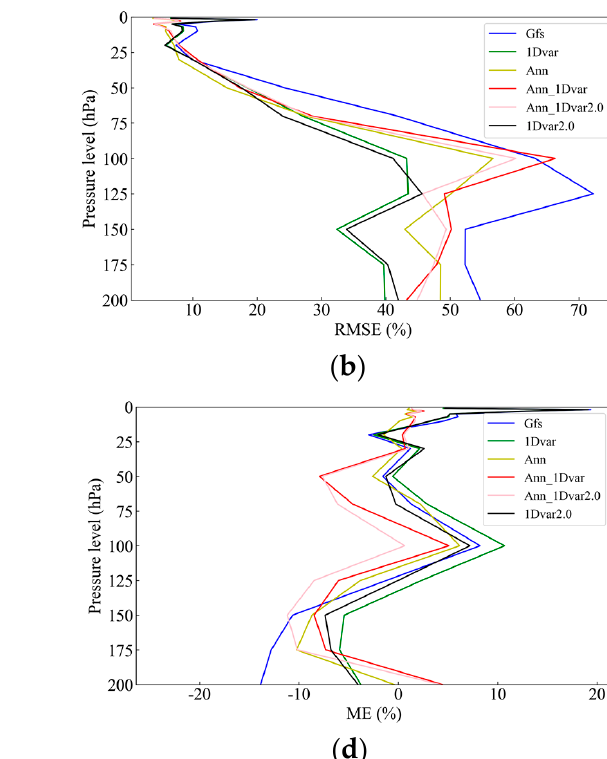
( d ) Figure 11. A comparison between the retrieved profile and AIRS product profile, where the true values are taken from WOUDC ozone site data: ( a ) 10–600 hPa RMSE (%), ( b ) 10–200 hPa RMSE (%), ( c ) 10–600 hPa ME (%), ( d ) 10–200 hPa ME (%). The red line, 1Dvar, is the traditional 1D − VAR phys- ical retrieval algorithm retrieval ozone profile result obtained with GFS data as the initial profile. The green line, Ann_1Dvar, is the retrieval result obtained by adding the neural network method to optimize the initial profile combined with the traditional 1D − VAR physical retrieval algorithm. The blue line, AIRS, is the ozone profile of AIRS L2 Ozone product. 4.3. Effects of Temperature and Water Vapor on Ozone Retrieval We explored the influence of temperature and humidity on ozone retrieval, and car- ried out a verification analysis with the ERA5 reanalysis data as the true value. The input values of temperature and humidity profiles used in the Ann_1Dvar and 1Dvar retrieval algorithms were from ERA5 reanalysis data. By changing the input value of the tempera-